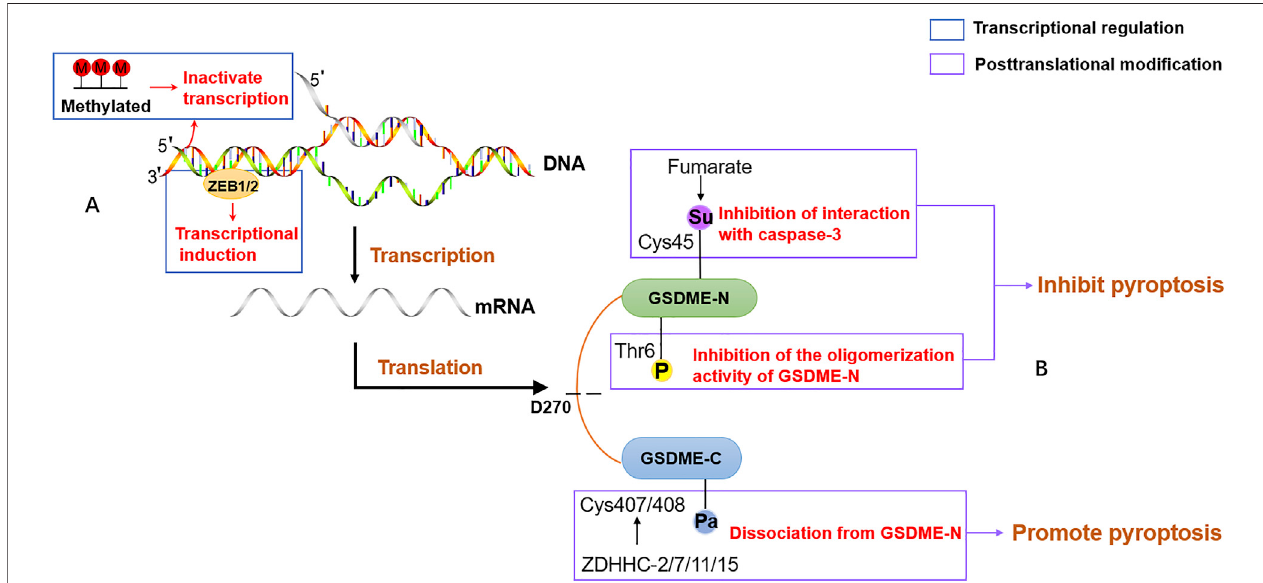
FIGURE 5 | The epigenetic regulation of GSDME. (A) The transcriptional regulation of GSDME. The promoter of GSDME is methylated or binds to EMT-activating transcription factor ZEB1/2, leading to inactivate transcriptional and expression induction. (B) The posttranslational modi fi cation of GSDME. The phosphorylation of residue Thr6 in GSDME blocks the oligomerization activity of GSDME-N to prevent the formation of membrane pores. Fumarate promotes succinylation at Cys45 in GSDME and reduces the pore formation of theplasmamembrane. ZDHHC proteins, including ZDHHC-2,7,11,15, palmitoylate GSDME at Cys407 and Cys408to facilitate the separation of GSDME-C and